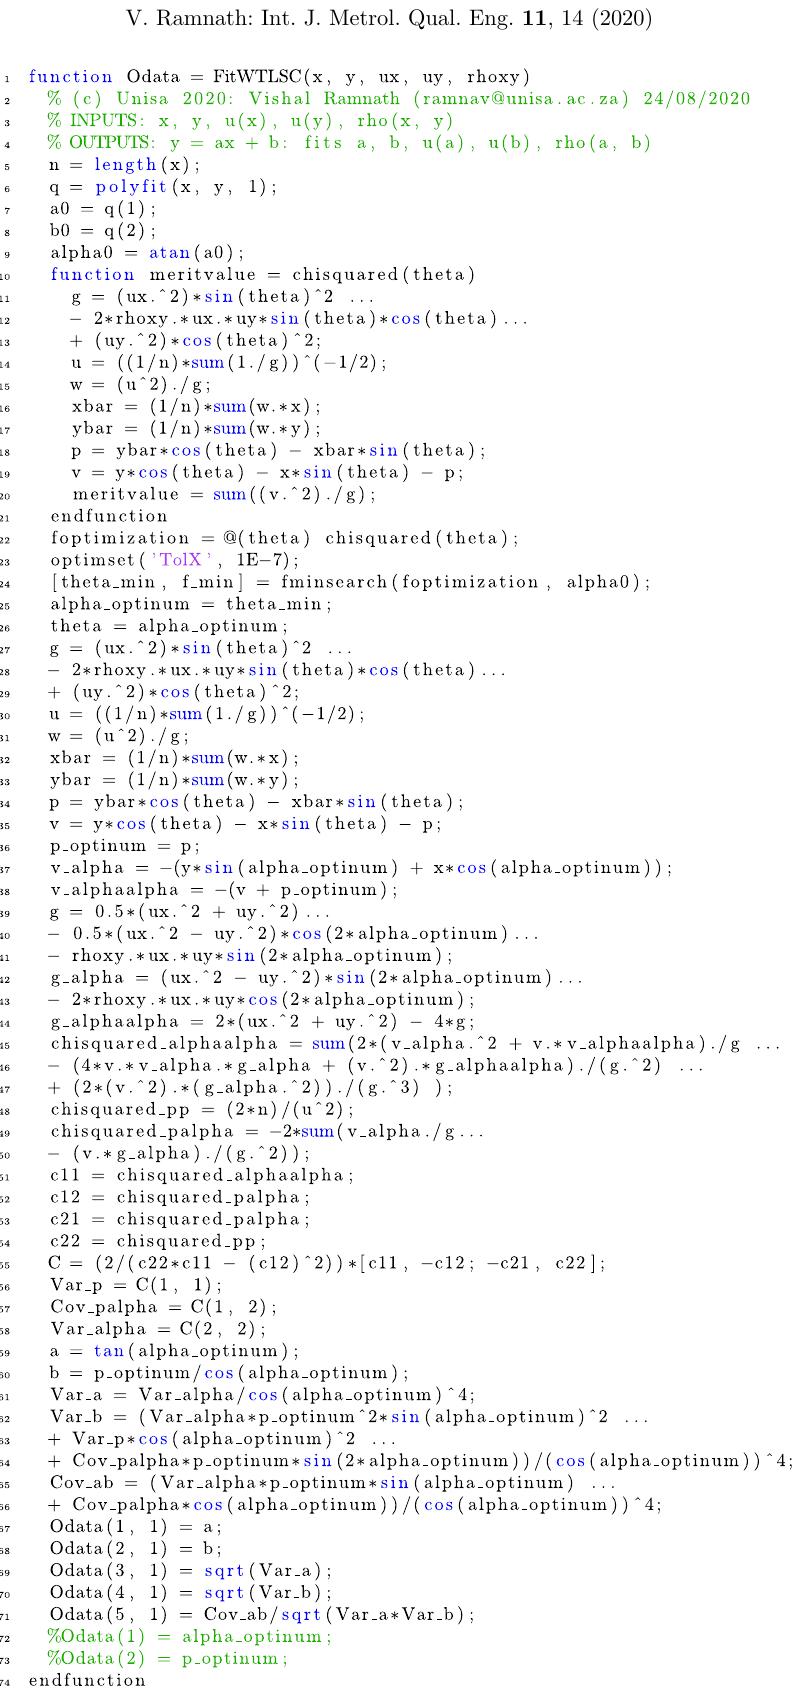
Fig. 1. Gnu Octave/Matlab function fi le to implement weighted total least squares with correlation algorithm. The x input and its standard uncertainty u ( x ) have the same physical units, and similarly the y output and its standard uncertainty u ( y ) also have the same physical units, whilst the correlation r ( x , y )= cov ( x , y )/( u ( x ) (cid:4) u ( y )) is